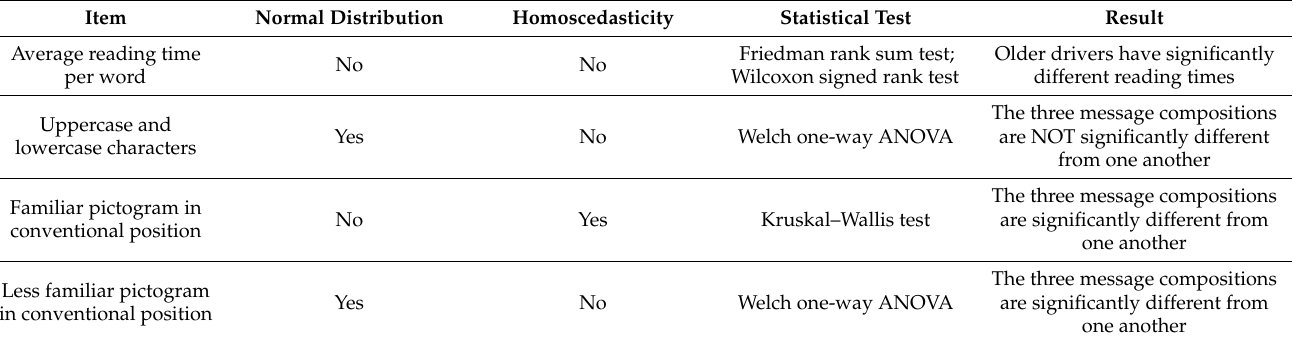
Table 7. Statistical test